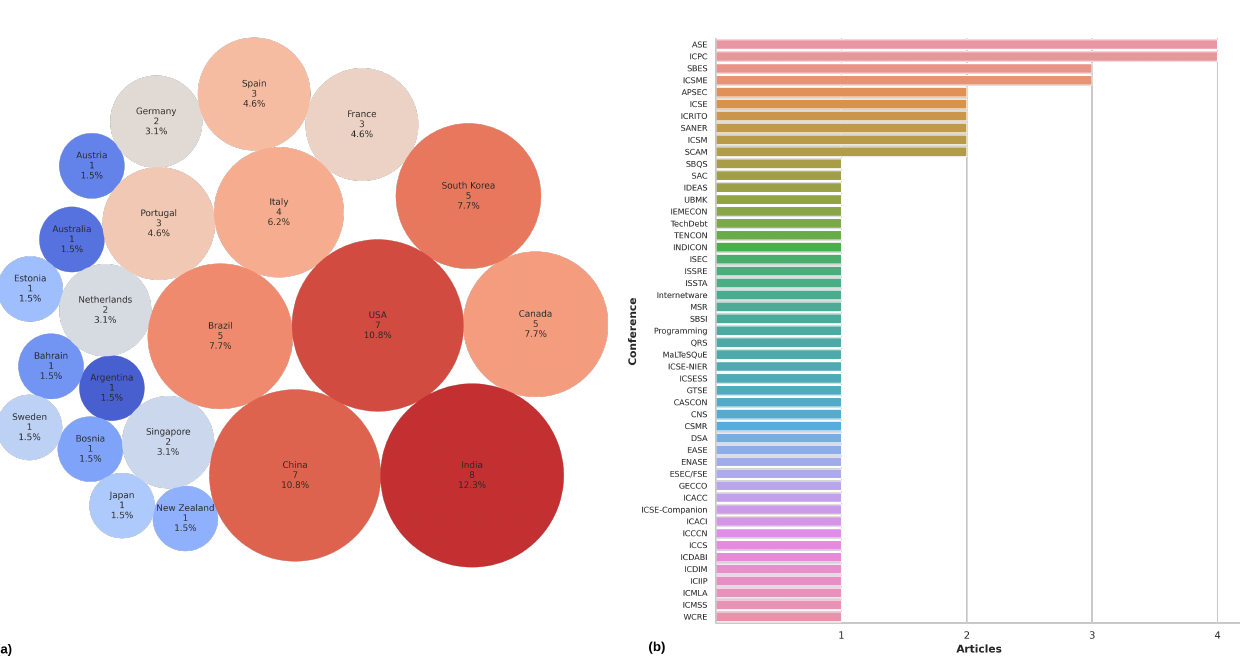
Figure A1. ( a ) Conferences by country and ( b ) conference